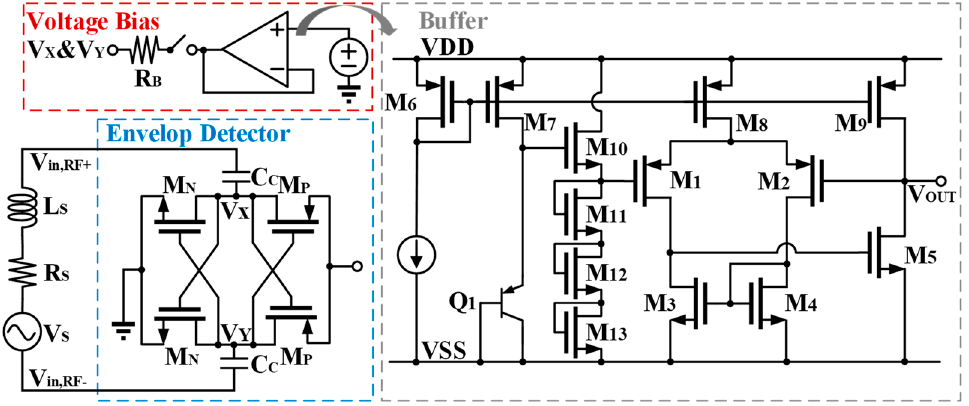
Figure 7. Schematic of proposed dual-mode envelope detector circuit.